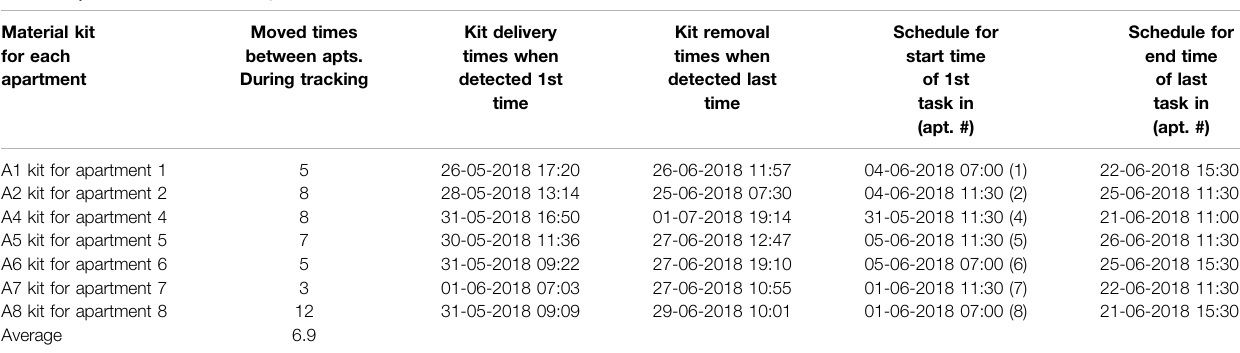
TABLE 4 | Moved times between apartments for each material kit. Material kit for